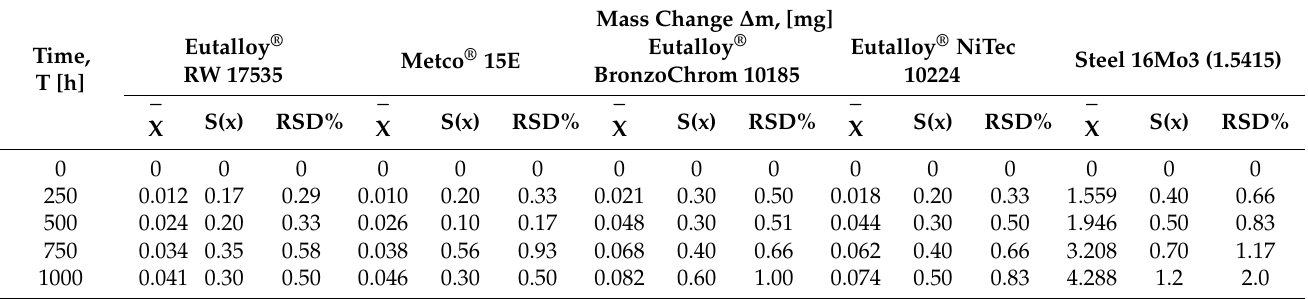
Table 8. Change in the weight of samples protected with protective coatings and the base material as a function of exposure to a corrosive atmosphere at a temperature of 800 ◦